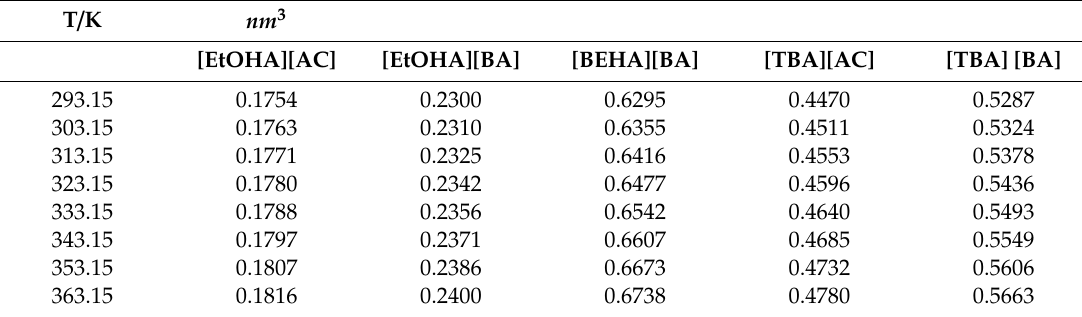
Table 7. Molecular volume ( V m ) of the ionic liquids calculated using Equation (7). T / K